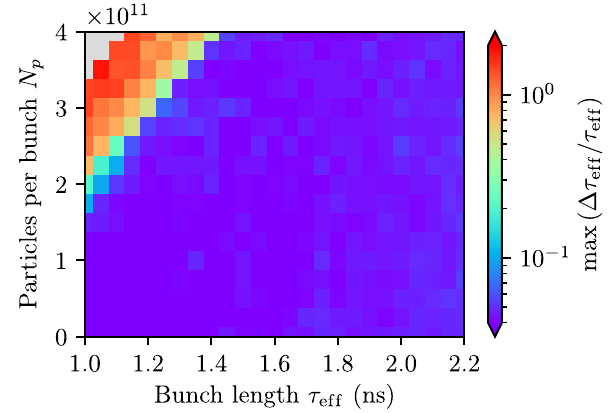
FIG. 20. Longitudinal stability map obtained from BL on D simulations for the SPS impedance model after LS2 (orange curve in Fig. 1) and double-rf configuration (BSM with a voltage ratio r ¼ 0 . 1 ). Background colors indicate the maximum relative oscillation amplitude of the bunch length. The SPS parameters are from Table